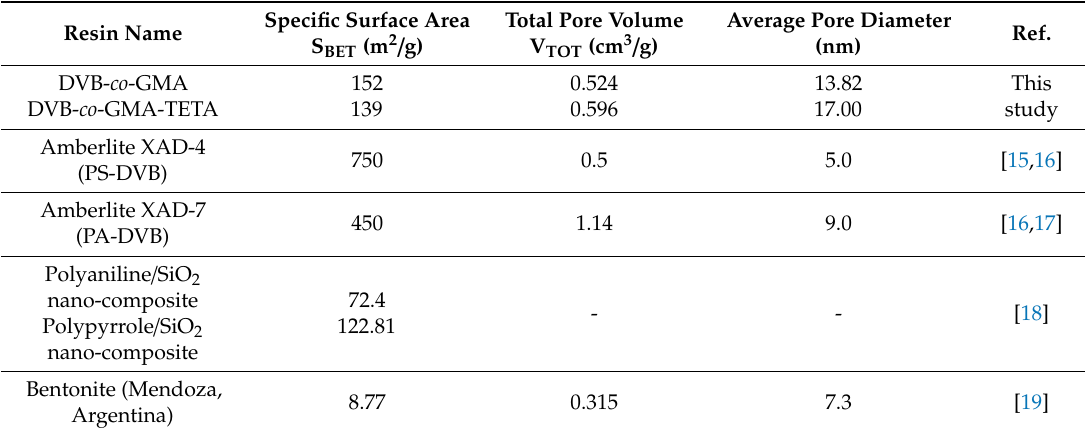
Table1. Parametersoftheporousstructuresofthedivinylbenzenecopolymerwithglycidylmethacrylate (DVB- co -GMA) and functionalized microspheres (DVB- co -GMA-TETA) compared with literature data.